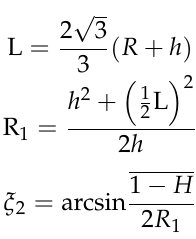
Figure 7. 1 c nodal stress calculation.